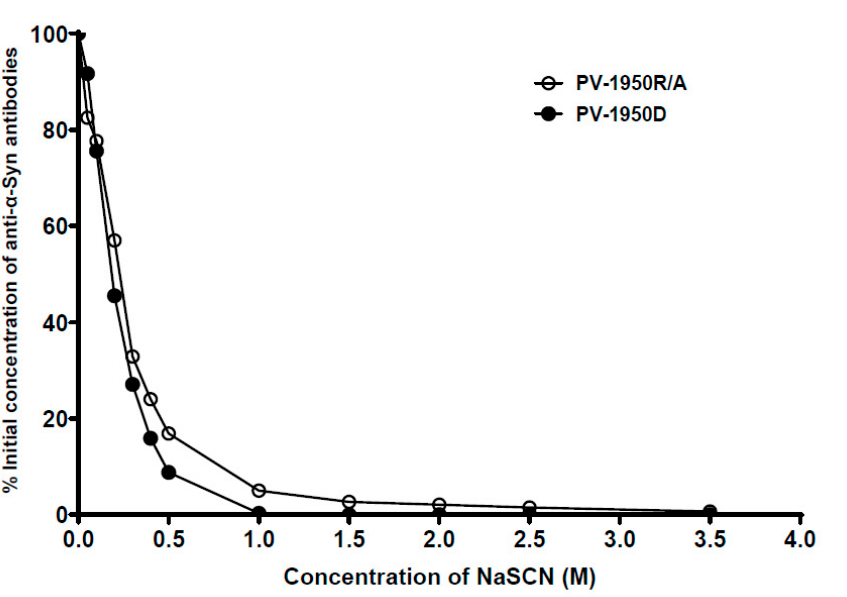
Figure 2. PV-1950R/A vaccine induced antibodies with slightly higher avidity for binding with h α -Syn protein than PV-1950D. Relative avidity for antibody–antigen binding was determined using sodium thiocyanate (NaSCN) displacement enzyme-linked immunosorbent assay (ELISA). The effective concentration of NaSCN required to release 50% of antiserum from the ELISA plate (half- maximal effective dose (ED50)) was 0.25 M for PV-1950R/A and 0.18 M for PV-1950D. ROC AUC score − 0.6, P = 0.3708. The concentration of antibodies was 80 ng/mL. Previously, we reported that IgG antibodies generated in wild-type mice immunized with PV-1950D recognized LB in the brain sections from several DLB cases [20]. In this study, we analyzed the binding of IgG antibodies purified from sera of mice vaccinated with the PV-1950R/A and PV-1950D to the amygdala sections of brains from DLB/AD combined pathology case (#41-04) characterized at UCI Brain Bank and Tissue Repository. The staining with Amylo-Glo, anti-total tau mAb, and antibodies specific to three B cell epitopes of h α -Syn, purified from sera of mice vaccinated with PV-1950R/A and PV-1950D, is shown in Figure 3A,B. The data demonstrated that antibodies purified from sera of mice immunized with either PV-1950D or PV-1950R/A recognized pathological h α -Syn in the amygdala regions of the brains from DLB/AD cases. Importantly, antibodies generated with both vaccines recognized LBs in the same brain regions as localized tau tangles and amyloid plaques (Figure 3). Of note, and as expected, these antibodies specific to three B-cell epitopes (aa85–99, aa109–126, and aa126–140) of h α -Syn did not stain control brains from non-DLB/AD cases (data not